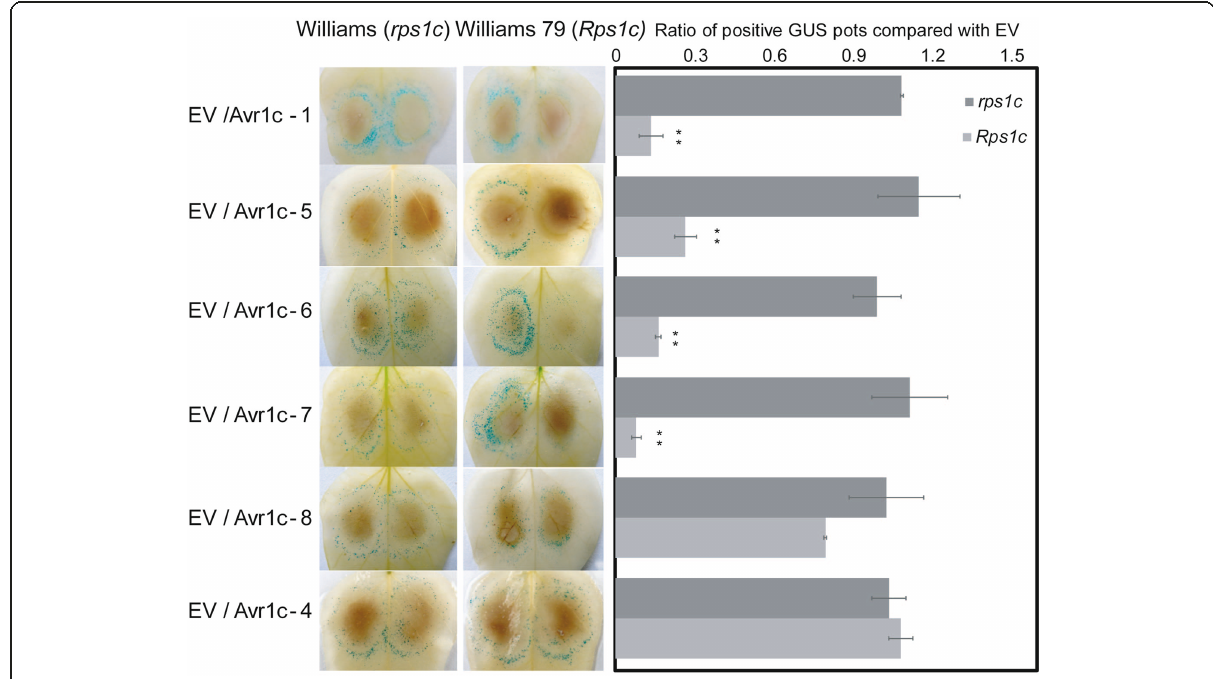
Fig. 3 The response of five Avr1c variants expressed in Williams ( rps1c ) and Williams 79 ( Rps1c ). Blue spots, surviving cells. Right, the ratio of GUS- positive blue spots following bombardment with Avr1c compared to EV. Bars represent standard errors from three independent replicates. **, P < 0.01 by t